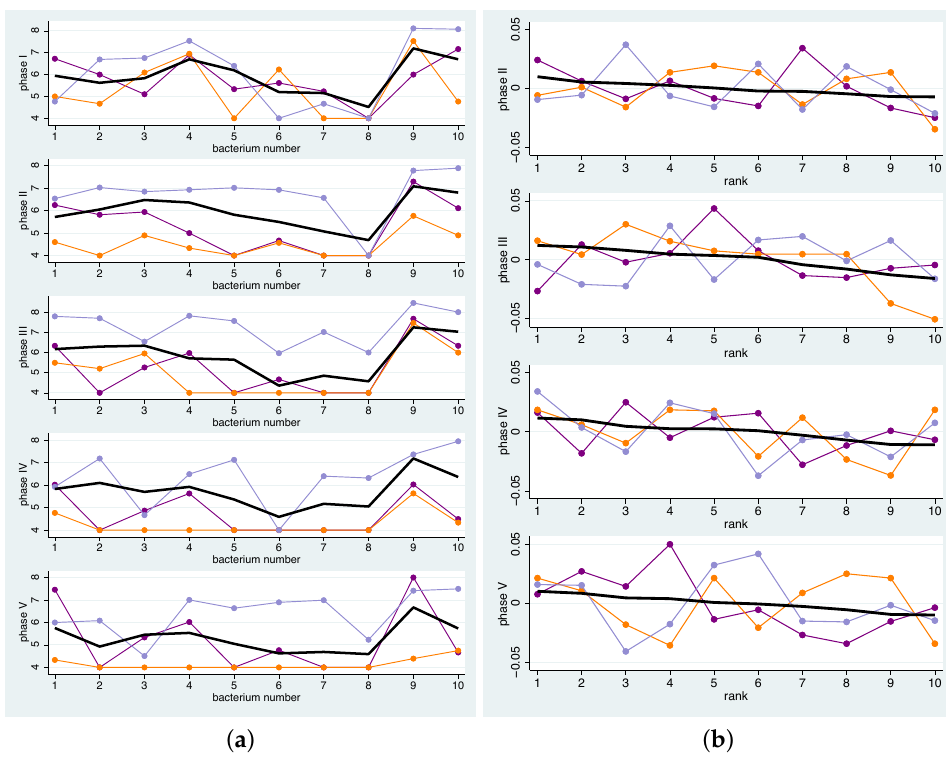
Figure 6. Individual patterns for atypical responders 6 (purple), 8 (orange), and 11 (lavender). Black line: population mean. ( a ) Individual bacterial concentrations of all bacteria in phases I–V. For the bacterial colour scheme used, see Figure 2. ( b ) Individual mean changes for phases II–V. The bacteria in each phase are presented in descending order according to their mean